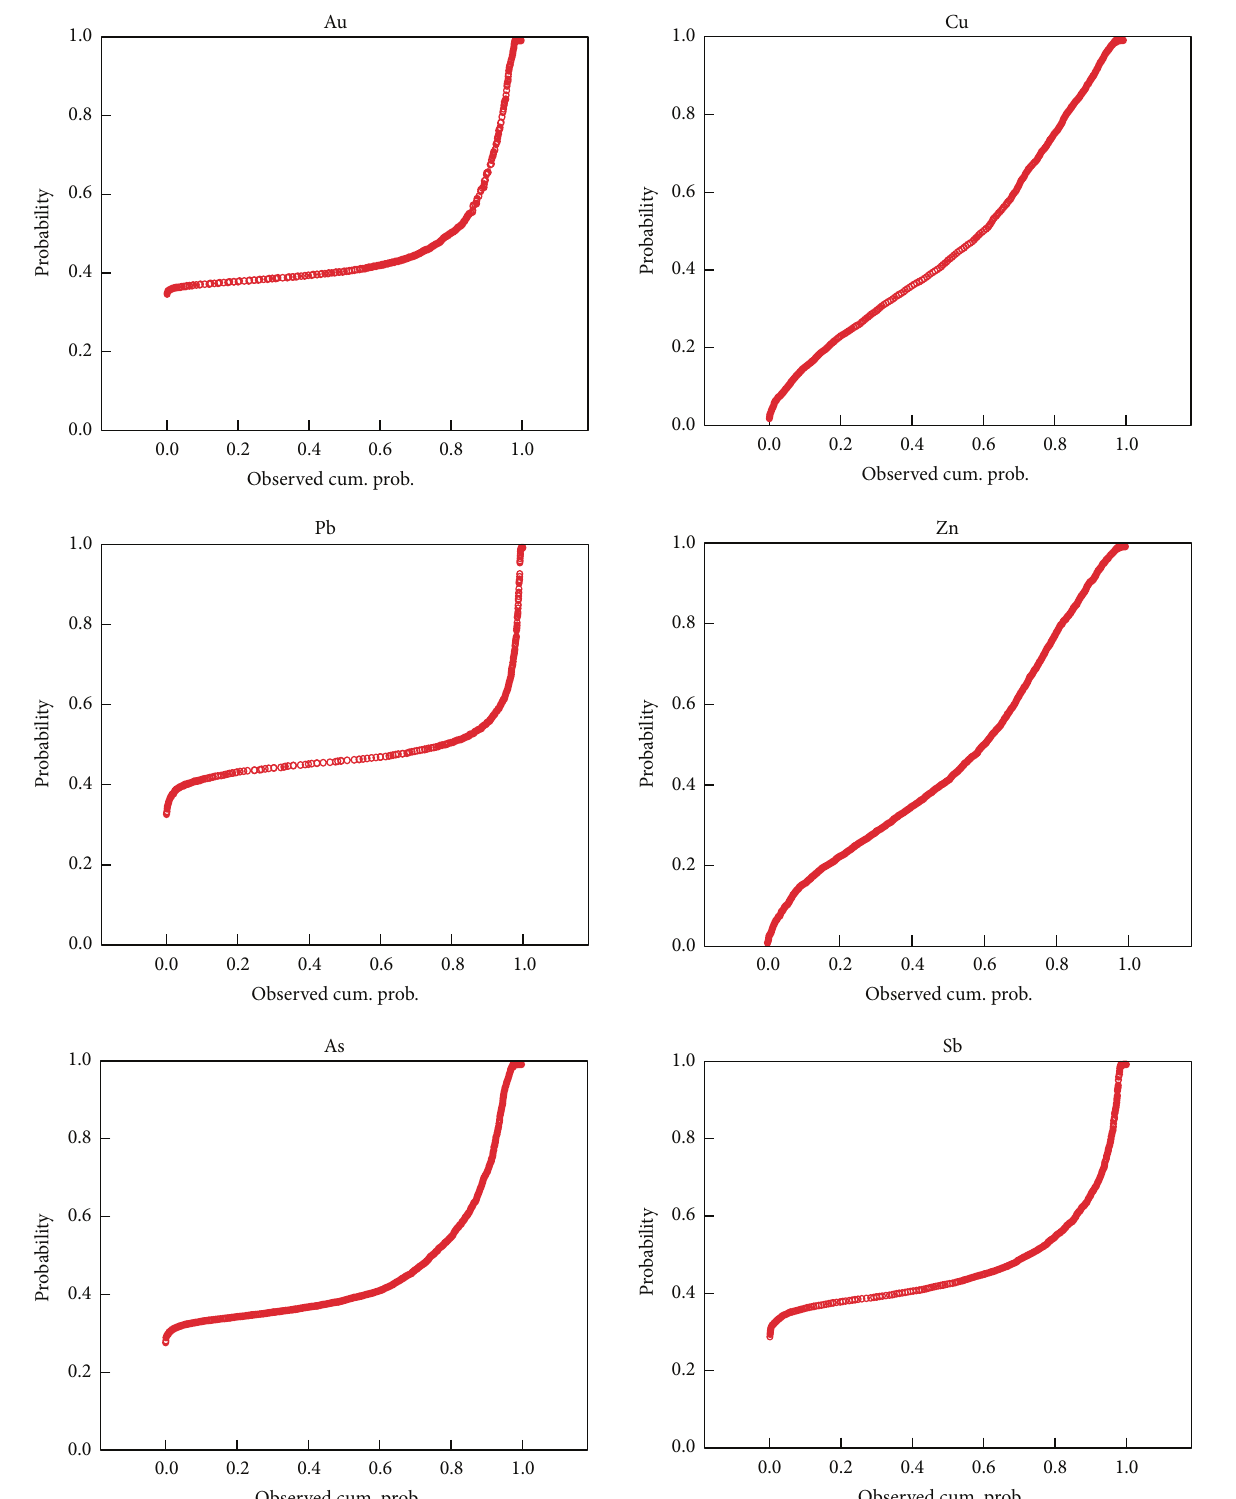
Figure 3: Normal probability plots of Au, Cu, Pb, Zn, As, and